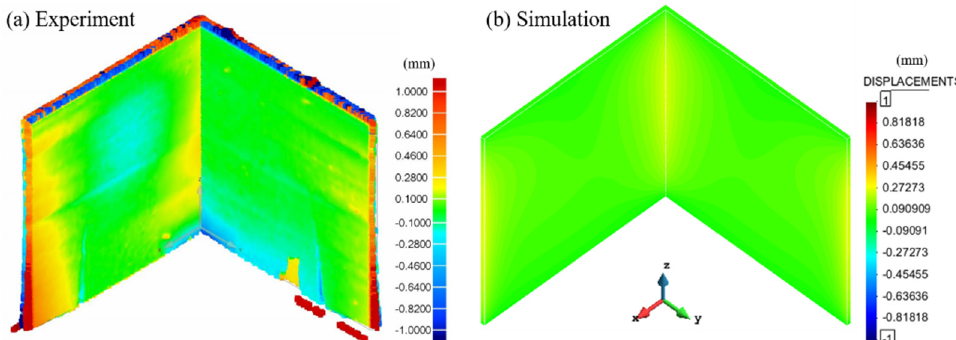
Figure 11. Comparison of the out-of-plane displacement fields obtained through ( a ) 3D scanning and ( b ) numerical simulation for the L-shaped structure.